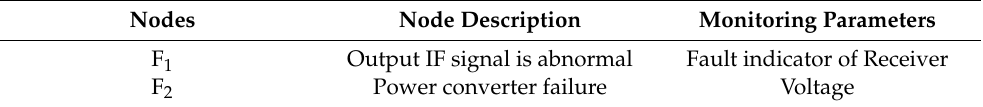
Table 1. Description of faults.